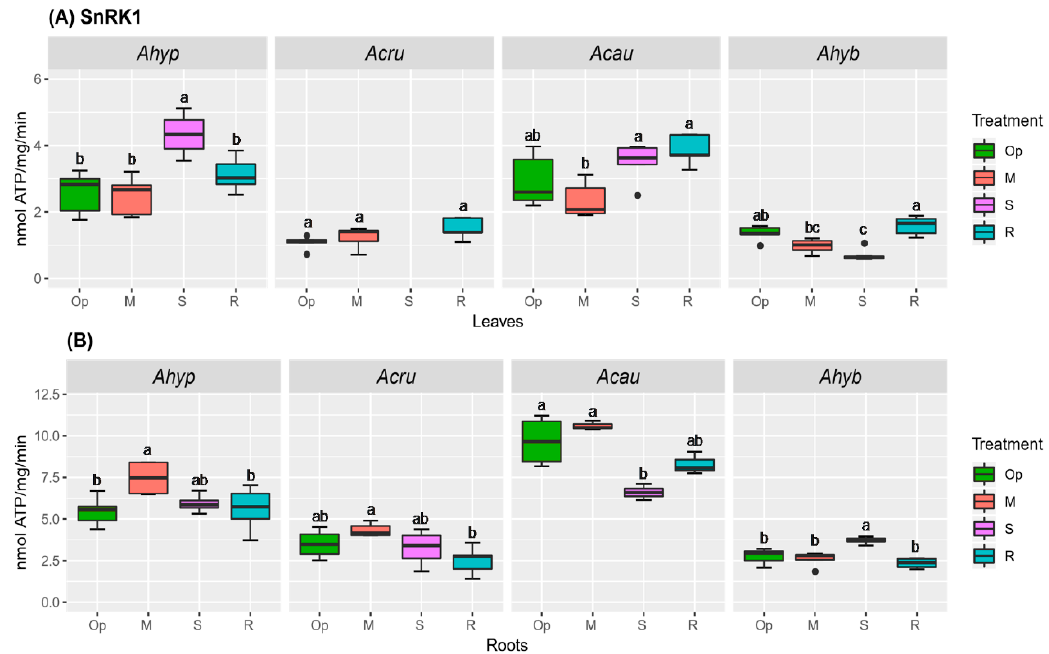
Figure 13. SnRK1 activity in amaranth plants subjected to water-deficit stress. SnRK1 activity in ( A ) leaves and ( B ) roots of Amaranthus hypochondriacus (Ahypo), A. cruentus (Acru), A. caudatus (Acau), and A. hybridus (Ahyb) of plants growing in optimal conditions (Op), subjected to moderate (M) or severe (S) water deficit stress, or allowed to recover from S, 1 day after normal watering was restored (R). Di ff erent letters over the box-and-whisker plots represent statistically significant di ff erences at p ≤ 0.05 (Tukey Kramer test; n = 9). Box-and-whisker plots show high, low, and median values. The results shown are those obtained from a representative experiment that was repeated in the spring-summer and summer-autumn seasons of 2015, respectively, with similar